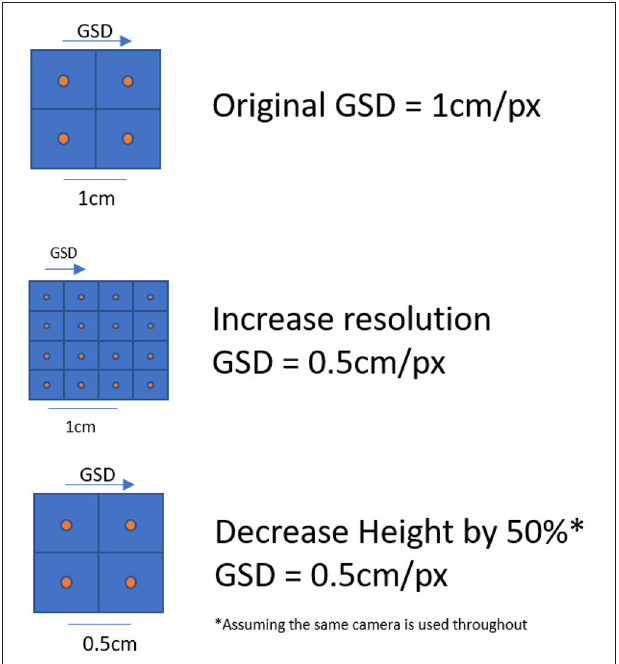
FIGURE 3 | How GSD is described and can be altered using either an increase in resolution, or decreasing the distance between the subject and the camera.